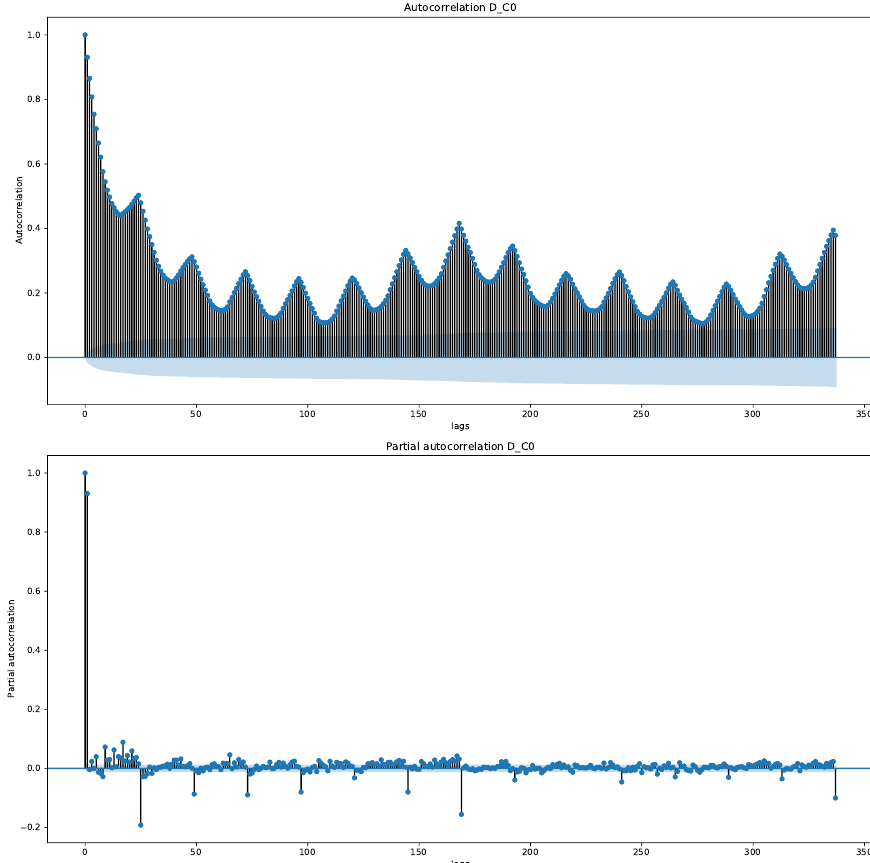
Figure 8. Autocorrelation and partial autocorrelation for the first demand class, D_C0. The first price class for the supply data is shown in Figure 9, and selected classes are shown in Figure 10. Again, there are daily and weekly seasonalities in the data, as expected (autocorrelation plots not shown). This supports the inclusion of the day-of-the-week dummy variables in the model.